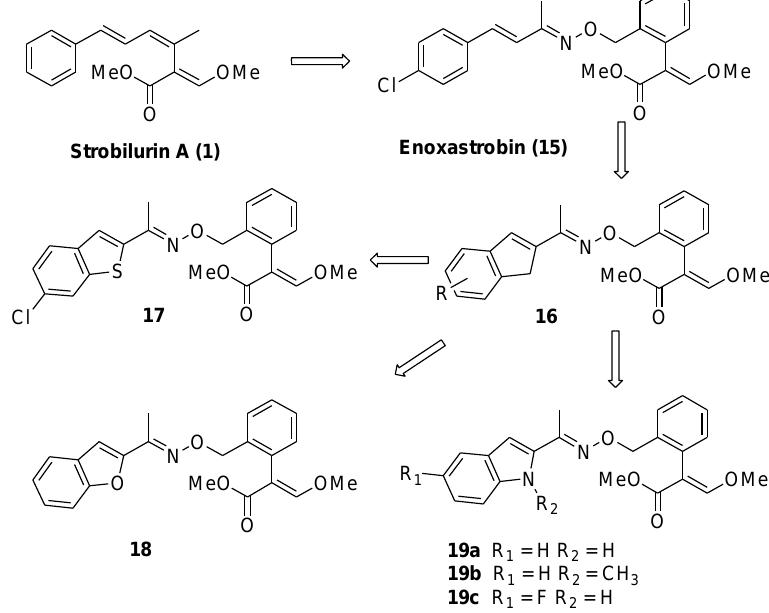
Figure 5. Enoxastrobin-inspired analogs.